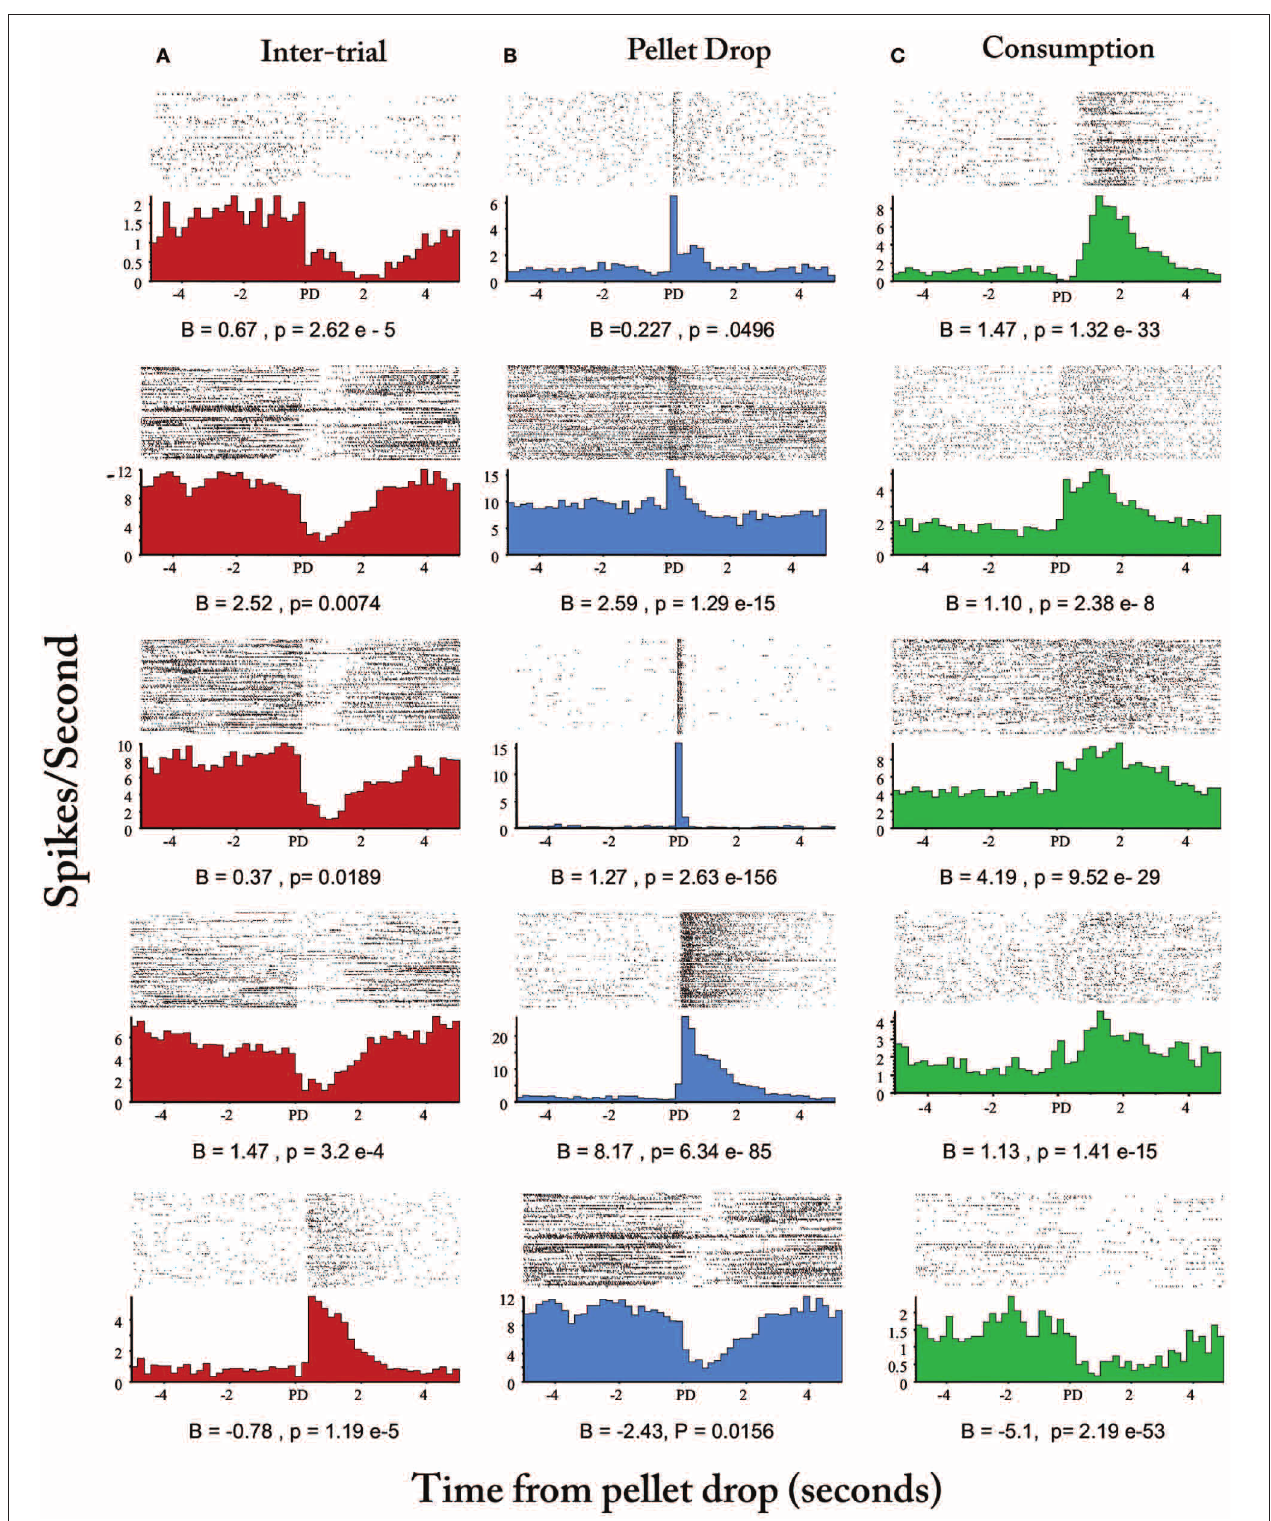
factor (red), (B) , for pellet drop factor (blue), and (C) for the consumption factor (green). Top four rows correspond to neurons with positive beta coefficients while the last row corresponds to neurons with negative